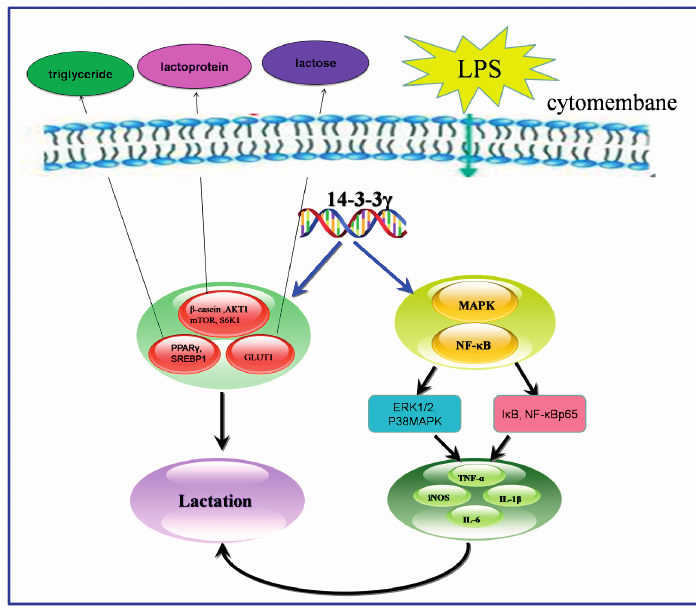
Figure 10. Diagram summarizing our findings. 14-3-3 γ may have a beneficial effect in depressing LPS-induced inflammatory response in DCMECs through inhibiting NF- κ B and MAPKs and up-regulating mTOR signaling pathway. Green arrows indicated that LPS get into the cell membrane; Blue arrows indicated that 14-3-3 γ regulated genes expression; Black arrows indicated that change of genes expression had